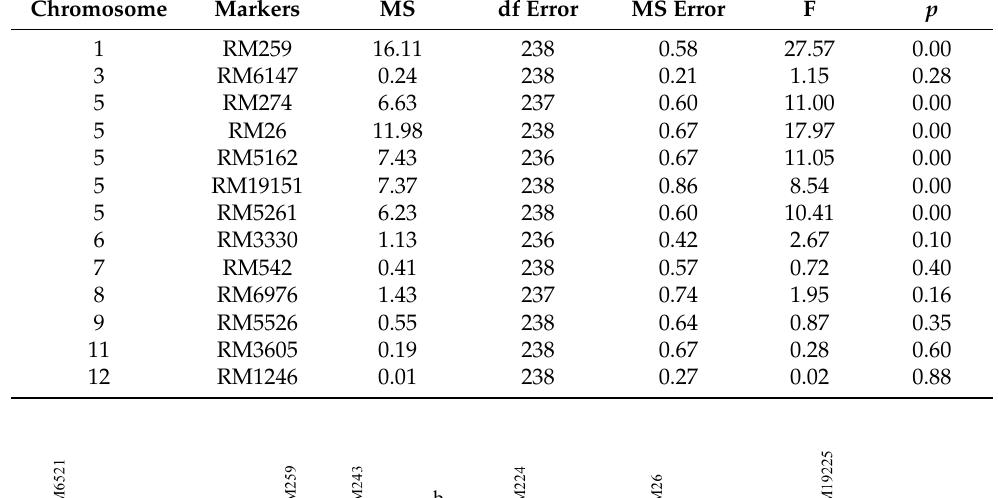
Table 3. One-way ANOVA of stem branch presence or absence using marker genotypes as groups. Chromosome